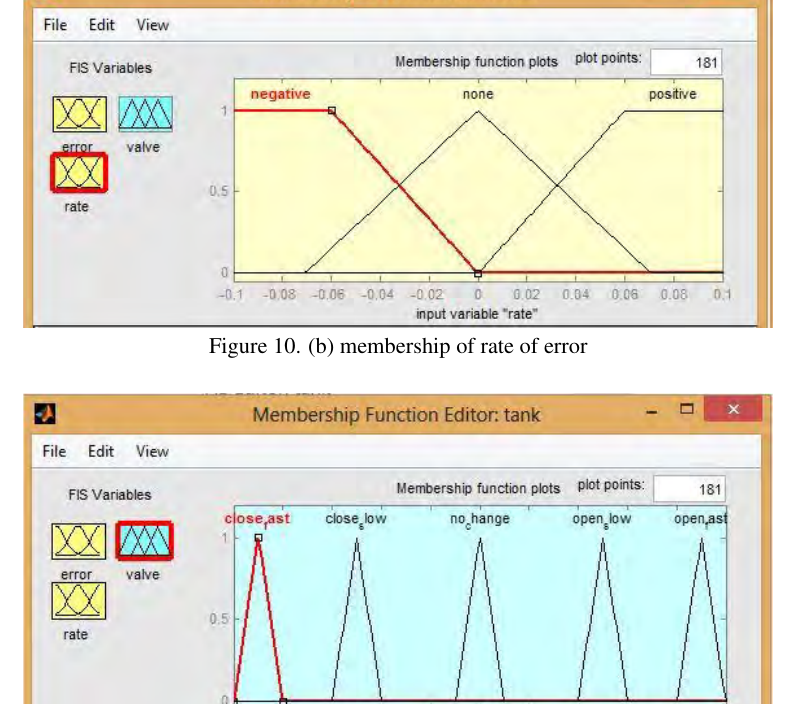
Fig.5. Shows the corresponding rule editor window in the MATLAB fuzzy logic toolbox. Fig.9 shows the rule editor window in MATLAB FLC toolbox.